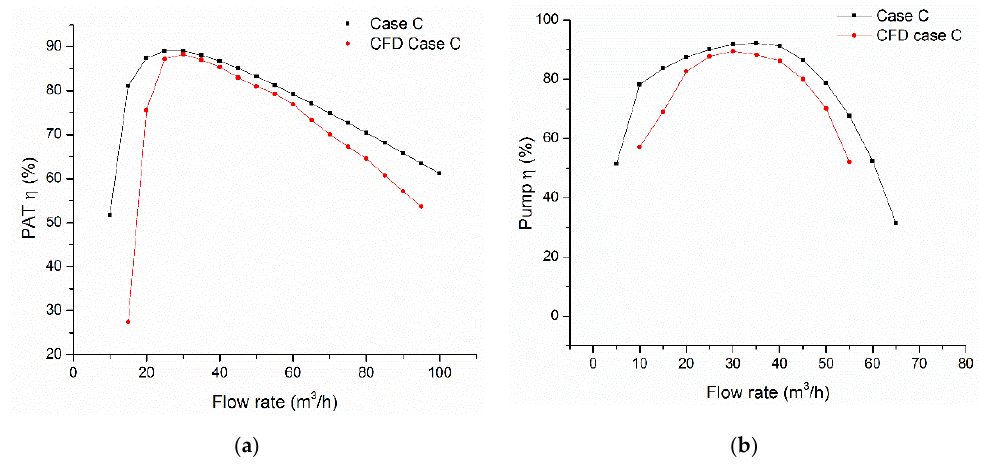
Figure 21. Prediction of energy performance in ( a ) under PAT mode ( b ) under pump mode.